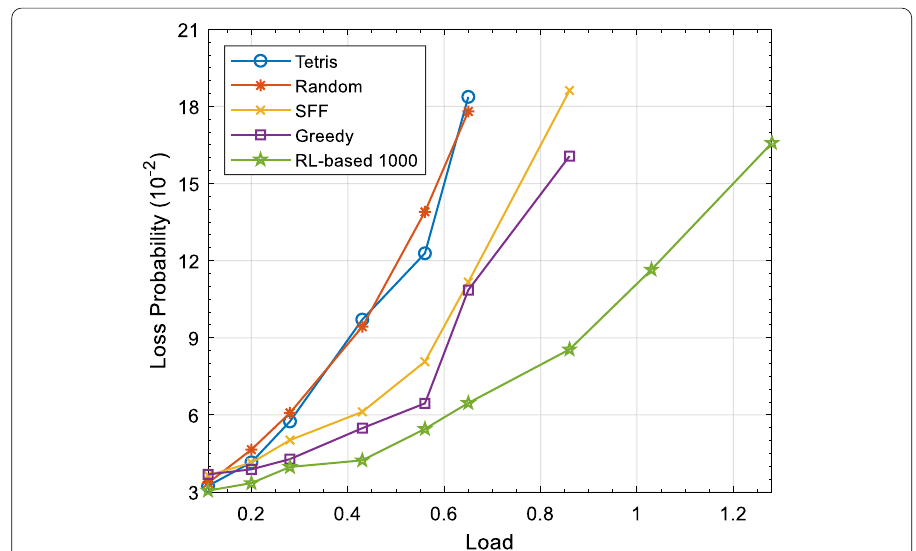
Fig. 11 Loss probability with D MAX = 1 ms . The loss probabilities of the RL-based, Greedy, Random, SFF, and Tetris schemes with maximum delay constraint D MAX = 1 ms . The x -axis is the load, and the y -axis is the loss probability in Eq.